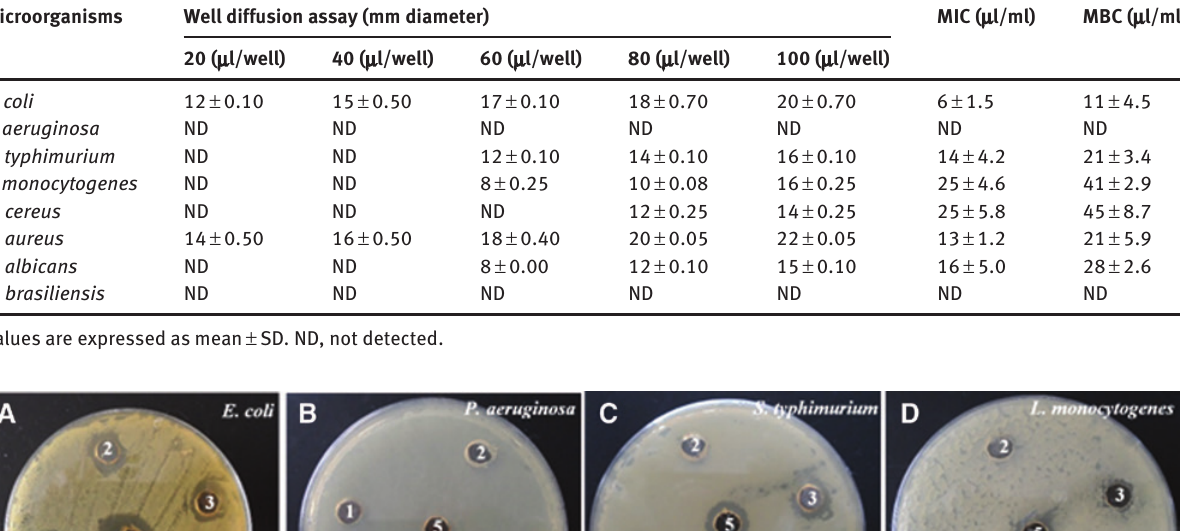
Table 6: Antimicrobial activity by well diffusion method, MIC and MBC of biosynthesized optimized silver nanoparticles (1 mm AgNO and 45 min) from optimized conditions. Microorganisms